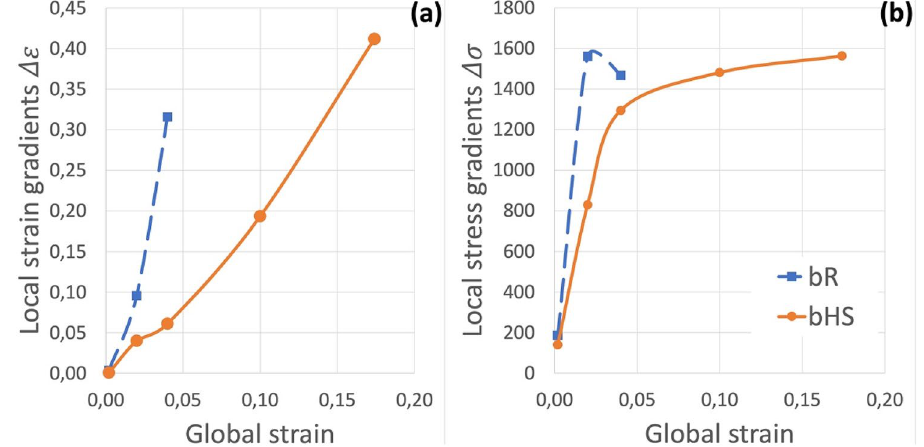
Figure 3. Development of maximum local strain ( a ) and stress ( b ) gradients in bimodal random (bR) and bimodal harmonic-structure (bHS) materials as a function of global strain ε eff